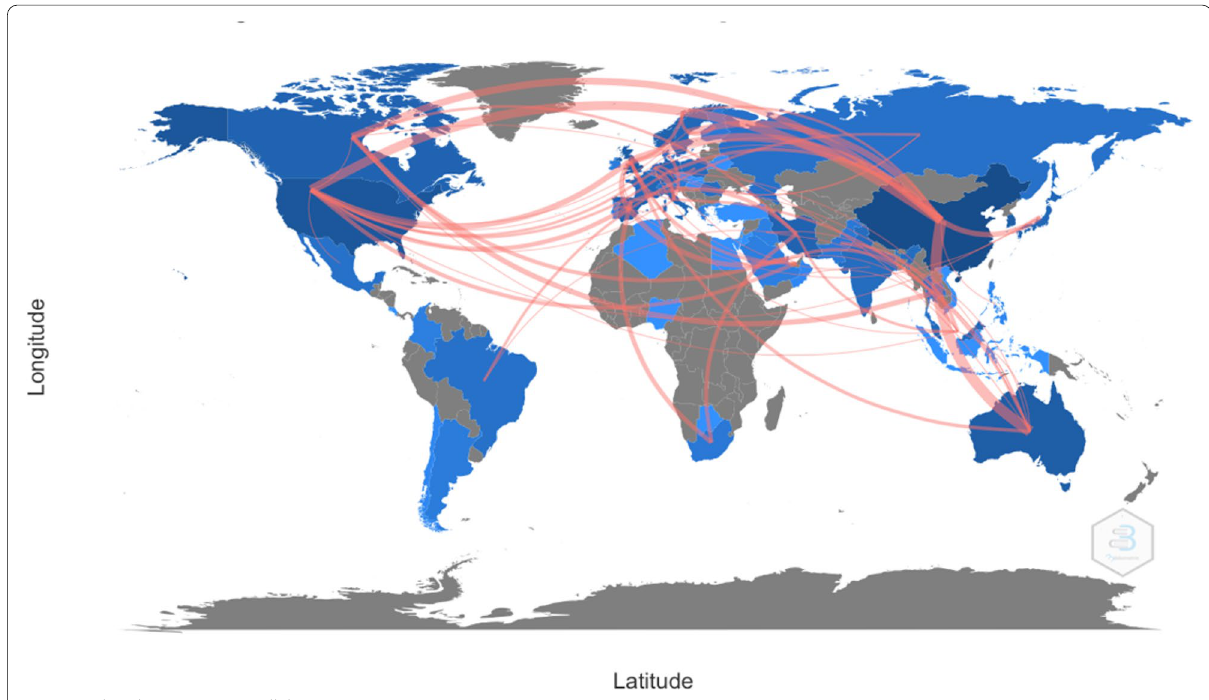
Fig. 35 Absorbent, country collaboration map